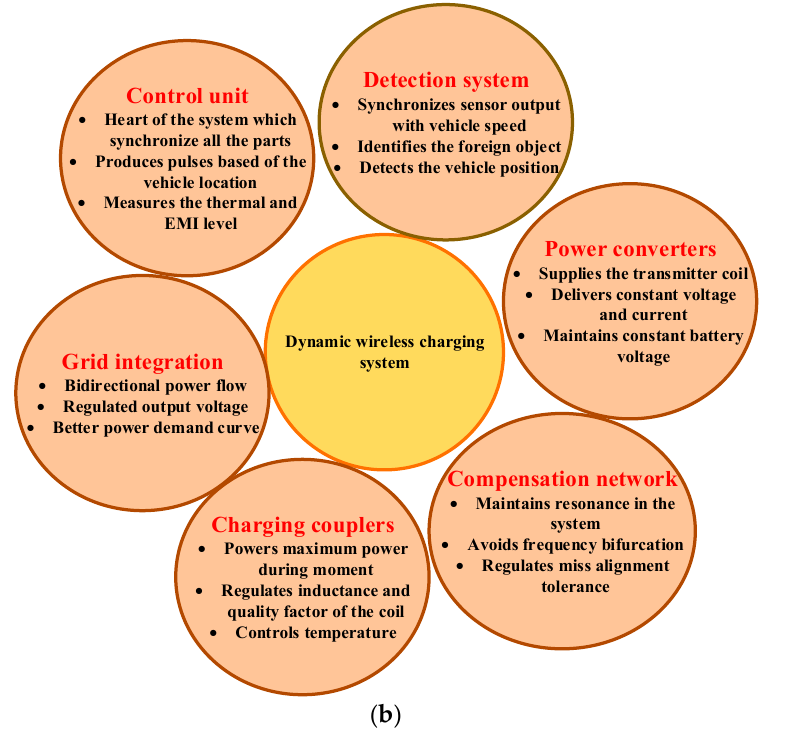
Figure 1. Wireless charging: ( a ) static and ( b ) dynamic.